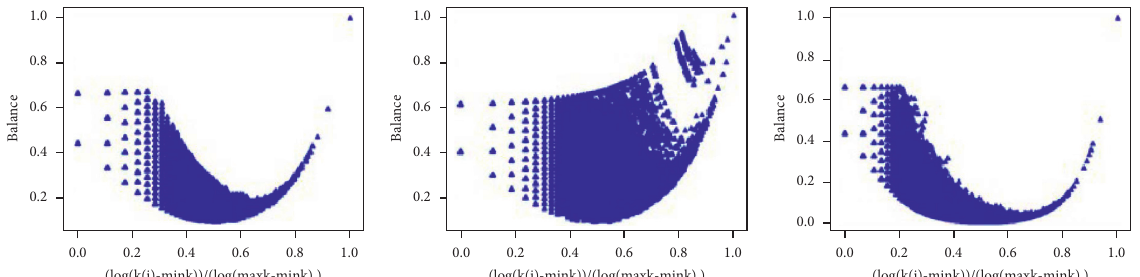
Figure 2: The balance distribution of nodes.